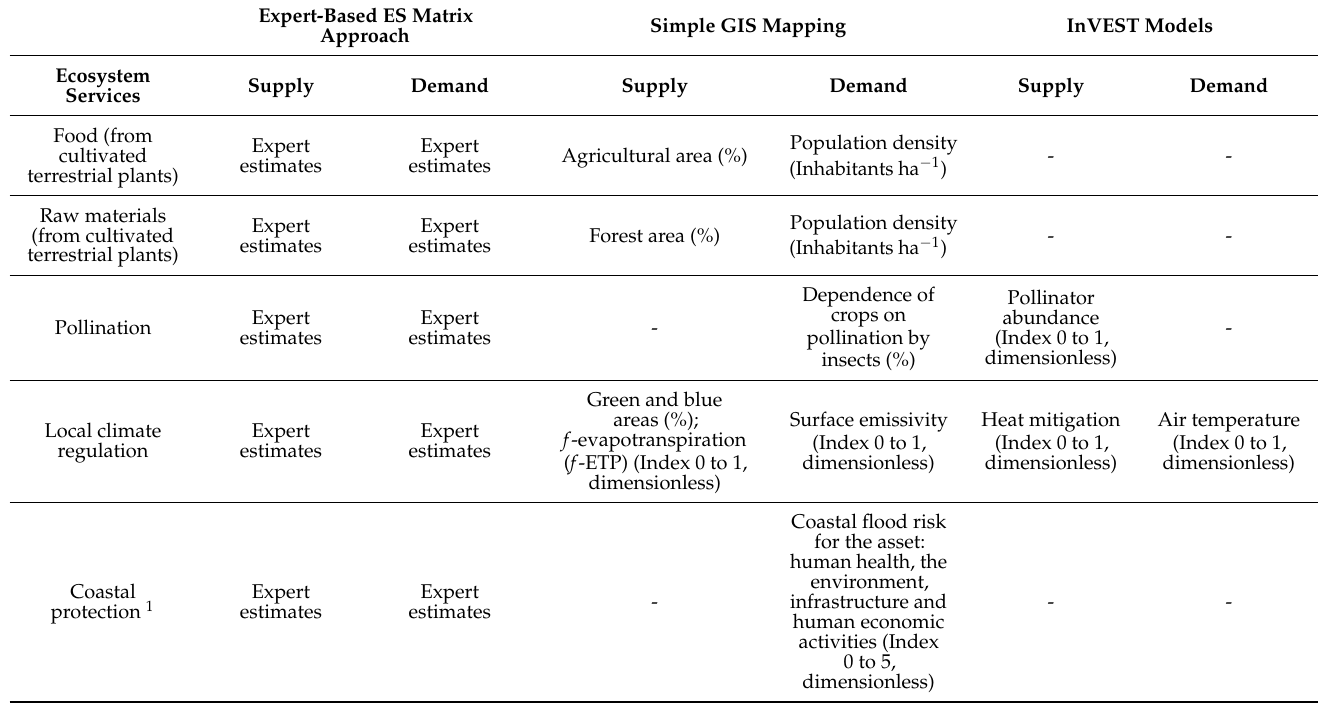
Table 2. Overview of the methods and indicators used to map ES supply and